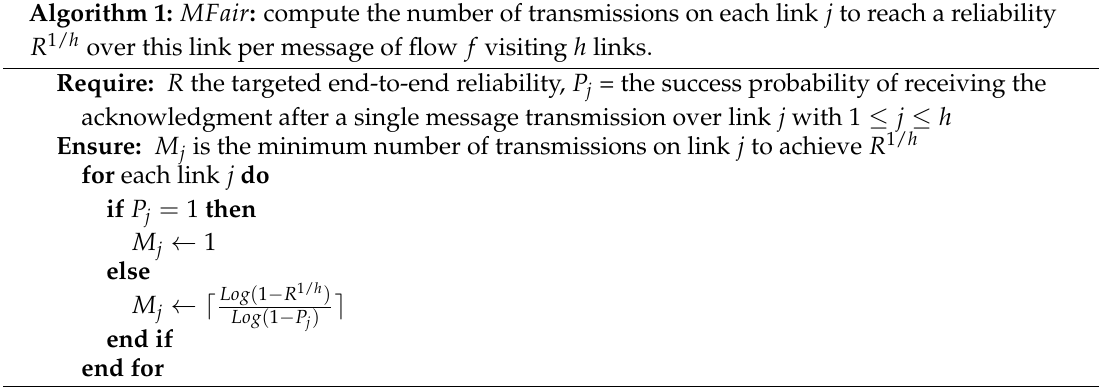
Algorithm 1: MFair : compute the number of transmissions on each link j to reach a reliability R 1/ h over this link per message of flow f visiting h